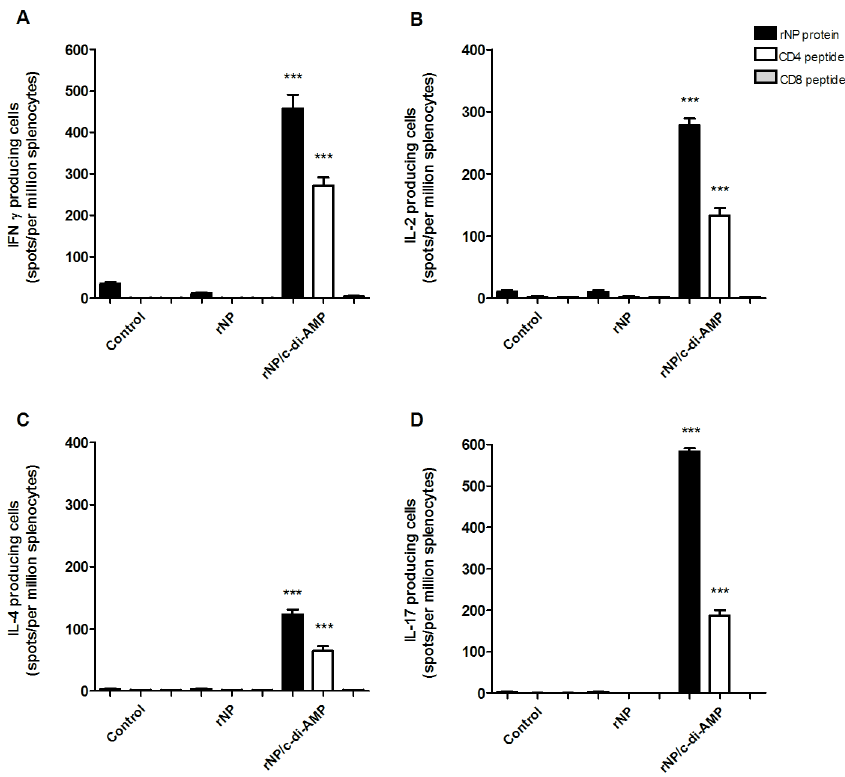
Figure 3. Analysis NP-specific cellular responses induced by vaccination. Splenocytes from immunized groups of mice were incubated for 24 or 48 h in the presence of rNP or peptides encompassing MHC class I and class II restricted epitopes of NP. The number of IFN- c (A), IL-2 (B), IL-4 (C) and IL-17 (D) producing cells was then determined by ELISPOT. Results are expressed as number of spots of cells producing cytokines per 10 6 spleen cells after subtraction of background values of unstimulated cells. The differences are statistically significant p , 0.001 (***) compared to the results of cells obtained from mice vaccinated with rNP alone.